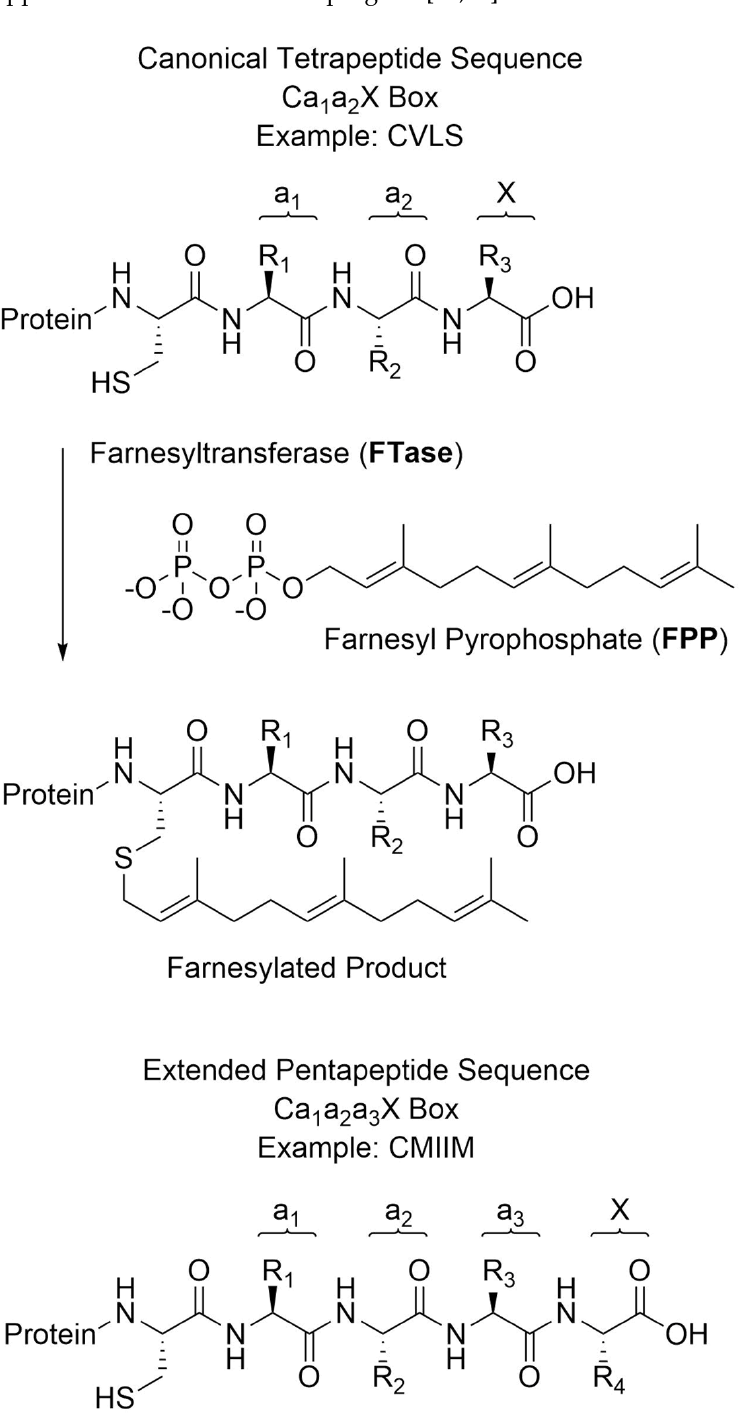
Figure 1. Diagram of the farnesylation of a C-terminal canonical tetrapeptide by FTase, as well as an example of an extended pentapeptide sequence.